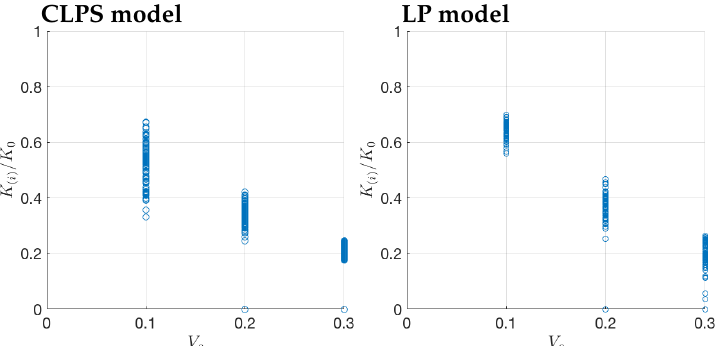
Figure 15. Dependence of K on V o when D o are found with reduced models CLPS and LP discussed in Section